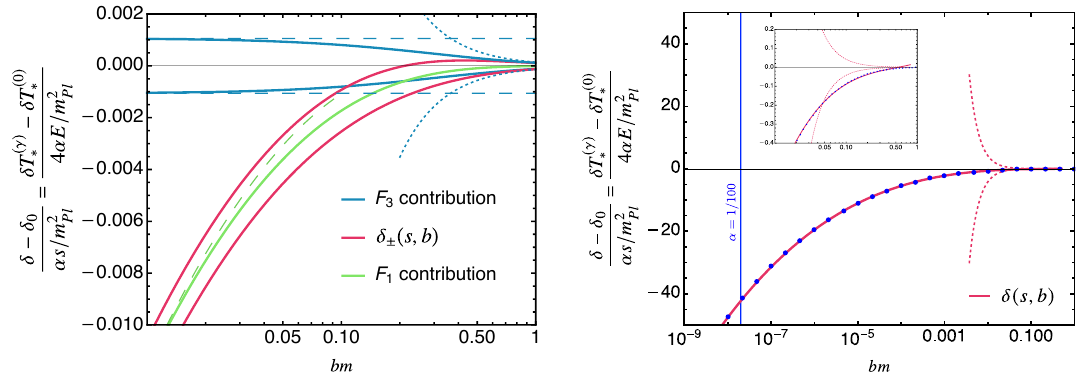
Figure 4 . Quantum corrections to the phase shift as function of bm . Dotted lines for large bm show the EFT result which, if allowed to continue to small bm , would eventually give a negative total phase shift and thus time delay. See discussion in section 3.2. Left: we plot the scalar case (as discussed, the spinorial case has similar features, so it is not shown here) that have two contributions coming from the form factors F 3 ( t ) , relevant at large impact parameters eq. (2.12), and F 1 ( t ) , which dominates as small bm eq. (2.18). The full numerical solutions eq. (2.6) is shown as solid lines, and their limiting behaviors as dashed lines. We have taken ¯ y = 0 . 27 to make the approximation close to the exact answer on the scales shown in the plot. Right: we plot the vector-loop case, i.e. QED embedded in a non-abelian gauge theory. The form factors are exponentially suppressed p by Sudakov resummation in the region bm (cid:28) exp( − π/ 2 α ) , as discussed under eq. (1.32), but this effect is not displayed here. The vertical blue line represents, for α = 1 / 100 , the value of bm below which Sudakov resummation can no longer be neglected. For larger values of the impact p parameter, exp( − π/ 2 α ) (cid:28) bm (cid:28) 1 , the fixed-order 1-loop approximation is instead accurate without resummation. In this region, F 1 ( t ) gives the leading contribution to the phase shift eq. (2.22) and it is plotted as a solid red line which interpolates the blue dots representing the exact numerical solution. We have taken ¯ y ’ 1 . 12 and γ ’ 0 . 12 in eq.